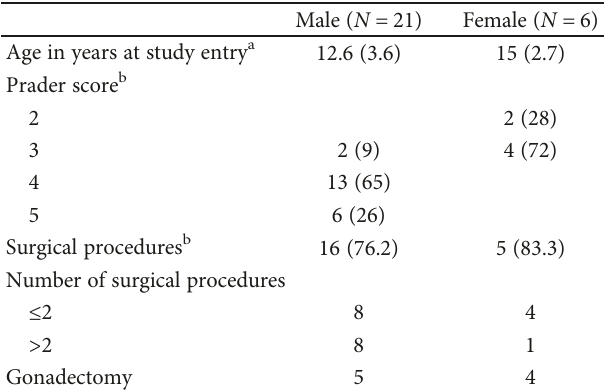
Table 2: Baseline characteristics of DSD cases.